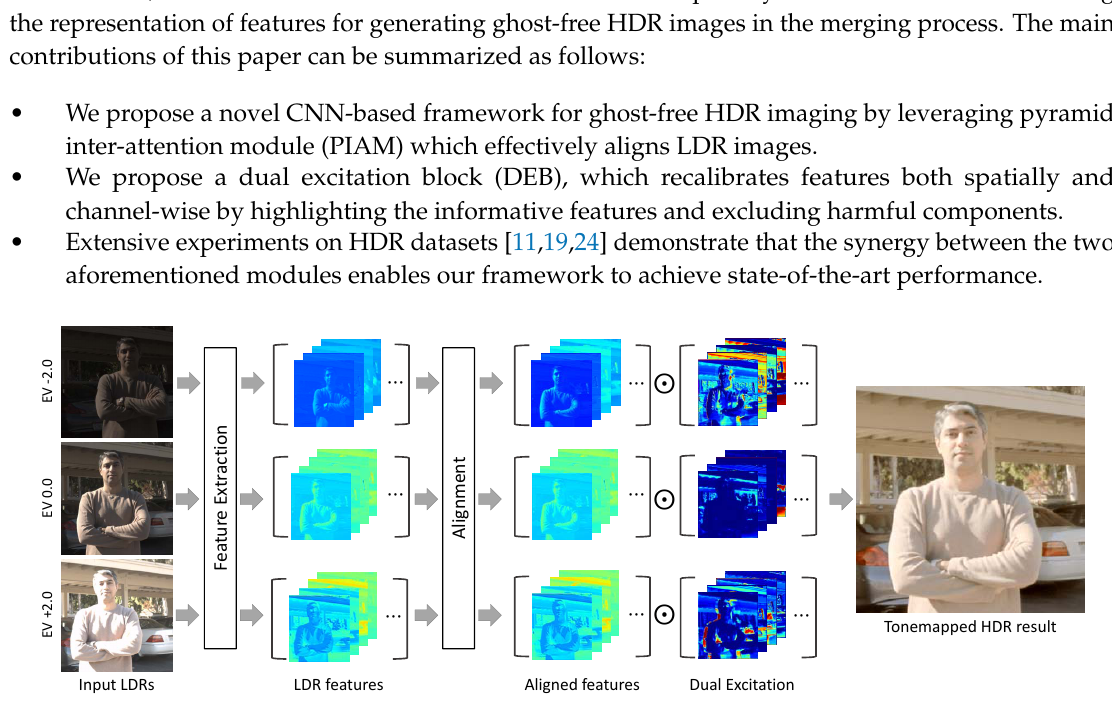
Figure 1. Given low-dynamic-range (LDR) images of a dynamic scene as inputs, the proposed method first generates the features using shared feature extraction network. Before merging them, the alignment network aligns non-reference features to a reference feature (i.e., EV0) using the pyramid inter-attention module (PIAM). In the merging process, we recalibrate these features to concentrate on more useful elements for producing a ghost-free high-dynamic-range (HDR) image, using both spatial and channel excitations. Finally, the proposed method outputs a tonemapped HDR